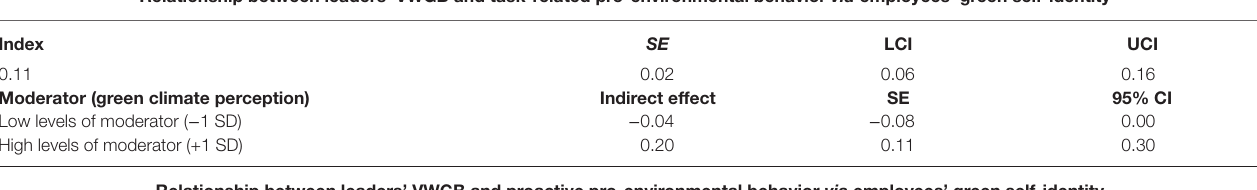
TABLE 4 | Results of conditional indirect